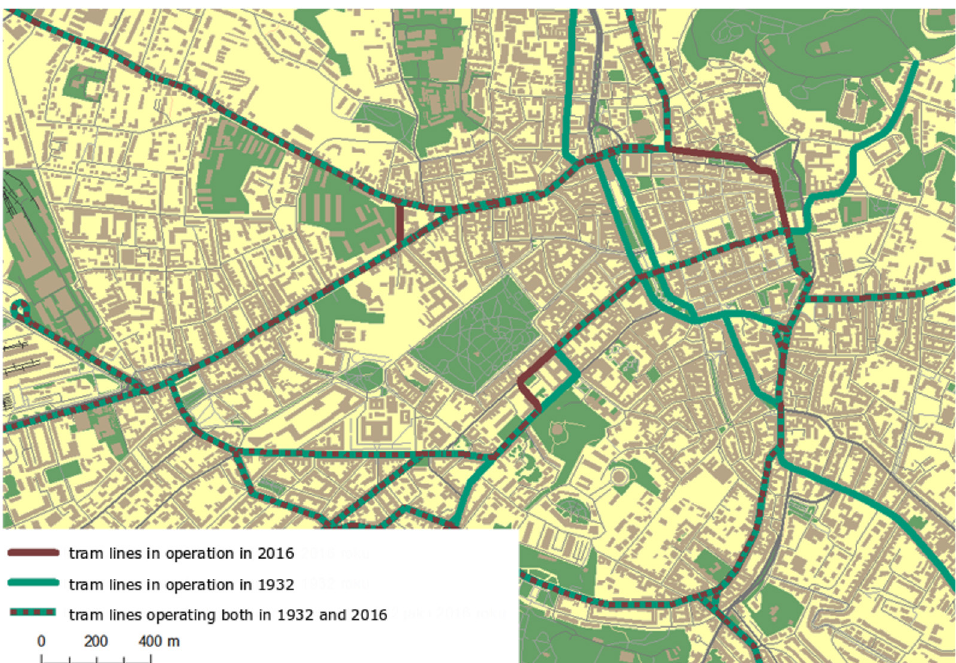
Fig. 6. Tram lines operating in 1932 and 2016 (part of the map fragment; own work based on OpenStreetMap vector